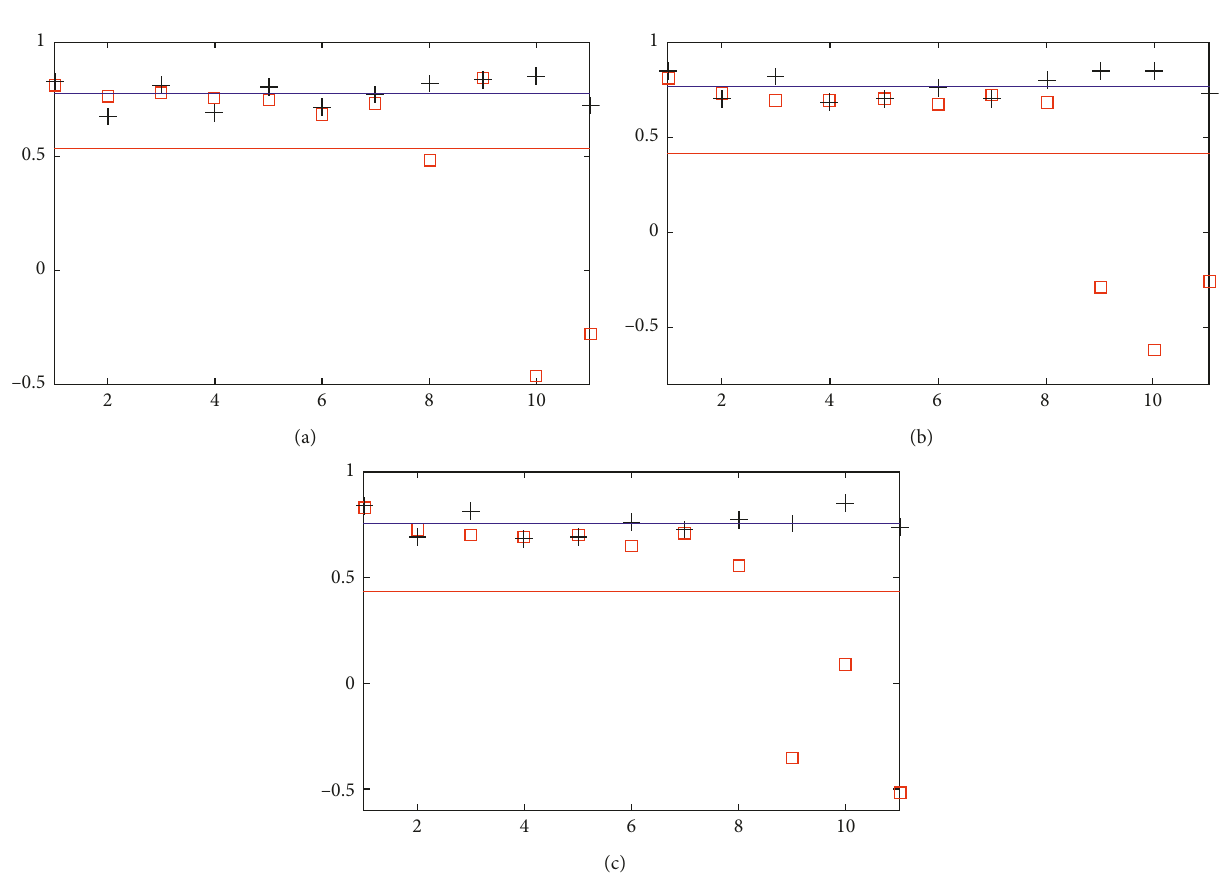
Figure 14: Distribution of DSF values depending on the MA process order: (a) version order of AR � 4, order of MA � 2; (b) version order of AR � 4, order of MA � 3; (c) version order of AR � 4, order of MA �